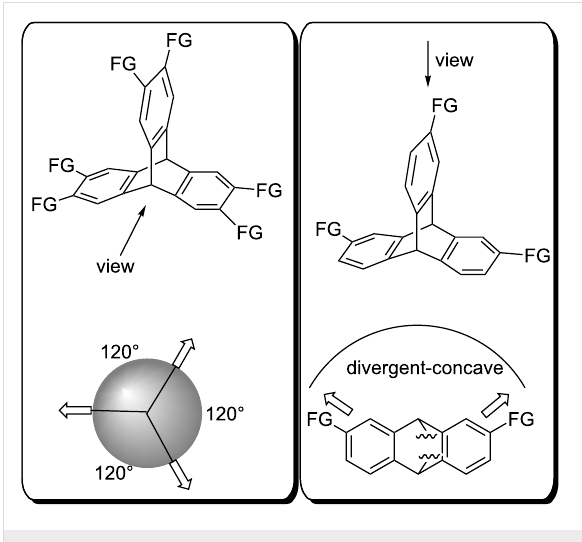
Figure 3: Structural features of triptycene